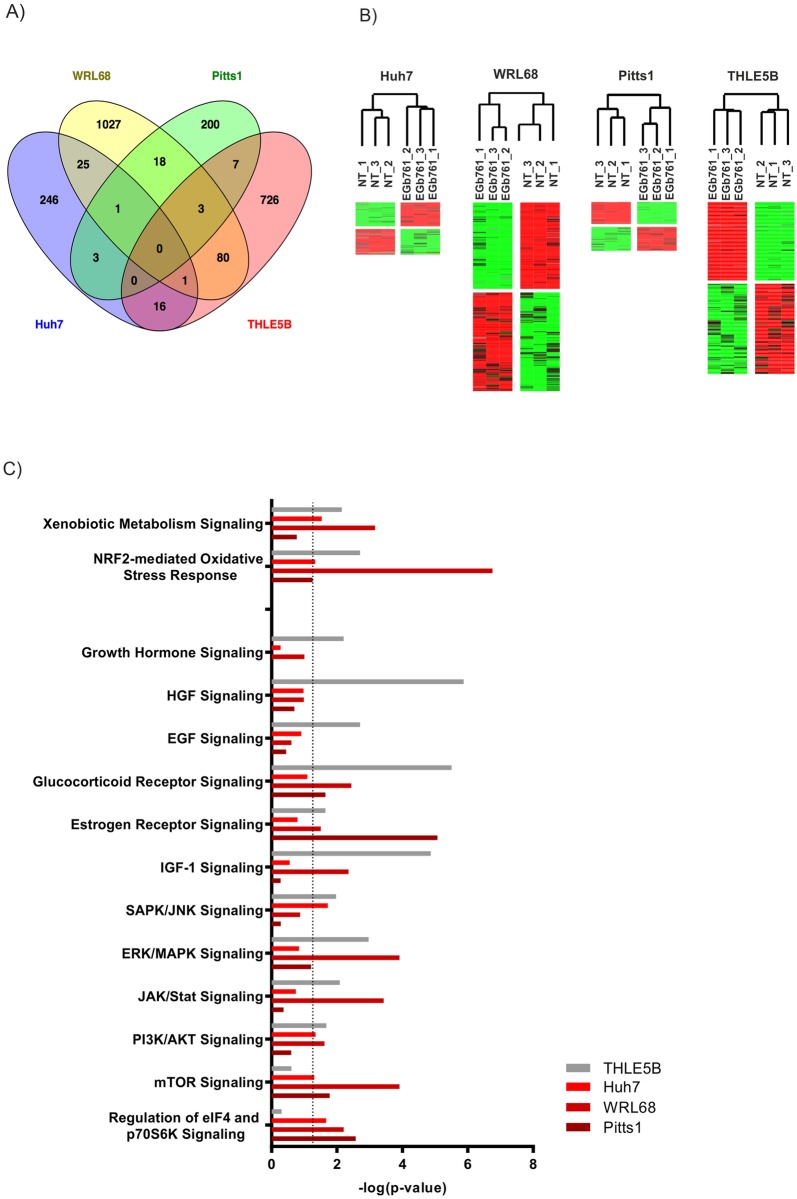
Molecular profiles of EGb761 treated hepatoma cell lines and human hepatocytes.(A) Venn diagram demonstrating the overlap of different gene expression signatures of indicated cell lines of treated (EGb761) versus untreated (NT) cells. (B) Unsupervised hierarchical cluster analysis based on the corresponding significant genes regulated by EGb761. (C) Canonical pathways significantly regulated by EGb761 and identified by Ingenuity Pathway Analysis. Pathways enriched in two or more cell lines (p<0.05) were included and associated to cell proliferation, -growth and -survival and oxidative/metabolic stress response.